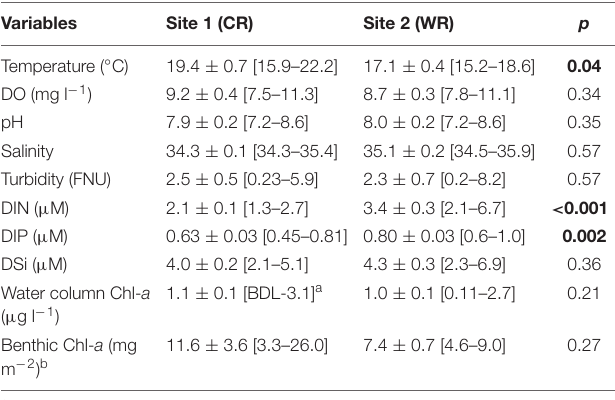
TABLE 1 | Summary statistics of the physicochemical, nutrients and Chl- a data presented as mean ± SD and range [min-max value] recorded during the study at Cape Recife (CR) and Willows Resort